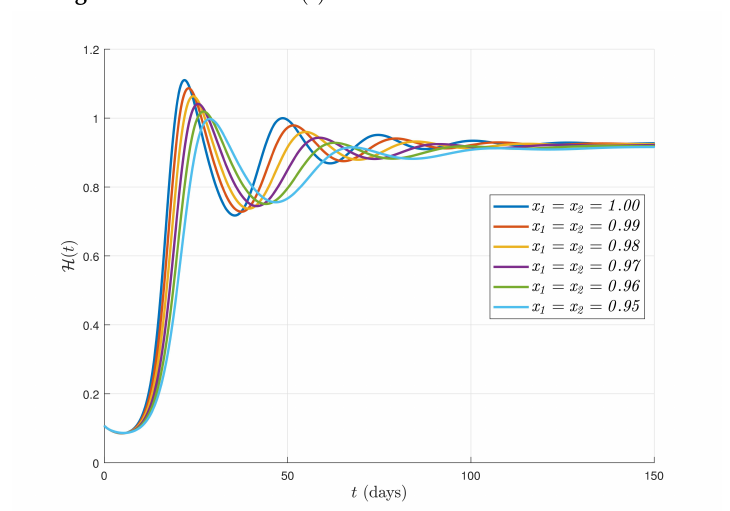
Figure 4. Behaviors of O ( t ) .